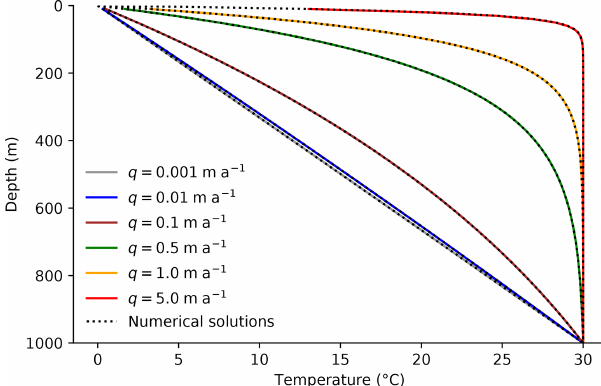
Figure 4. Validation of modelled advective heat flow in a one- dimensional system with an analytical solution (Bredehoeft and Pa- paopulos, 1965). Solid lines show calculated temperatures using the analytical solution and broken lines the numerical solution by